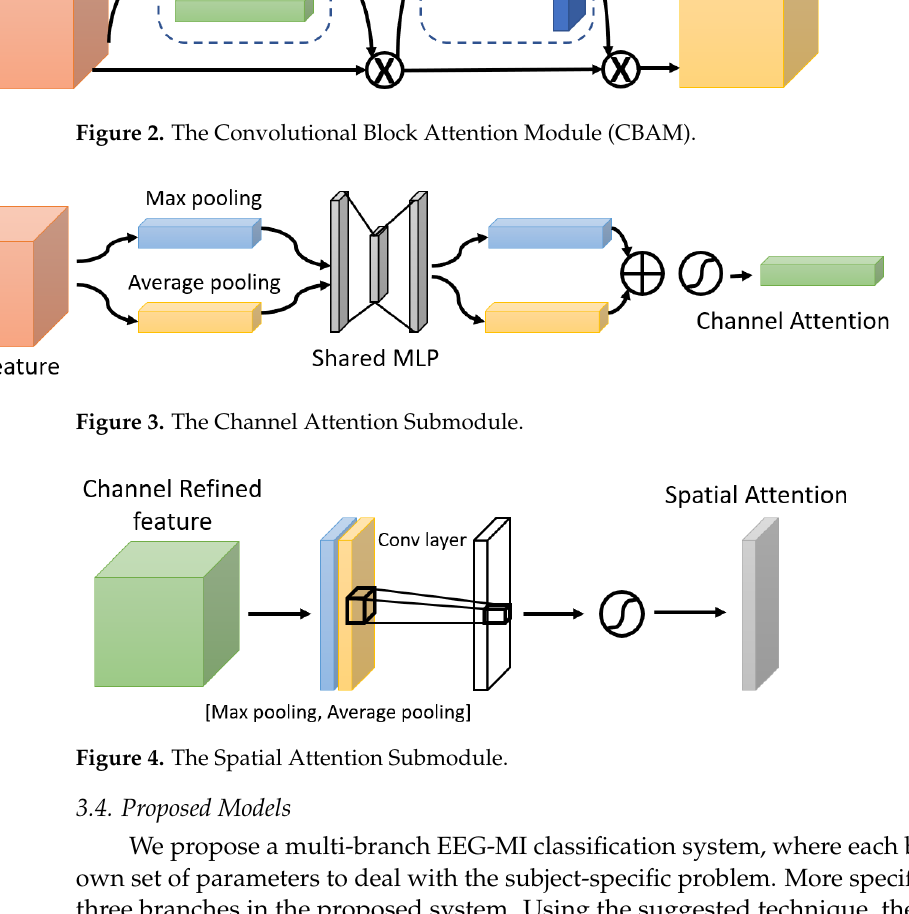
Figure 4. The Spatial Attention Submodule.